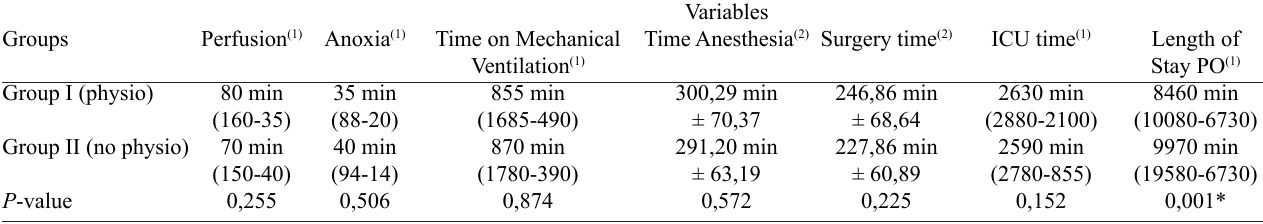
Fig. 4 - Median minute volume (VM ) variable at different times of the operation of each group analyzed. Friedman test for comparison of the moments in each group and the Mann Whitney test for comparison between groups at any time, *P<0.05. Table 3. Values for the infusion time, anoxia, mechanical ventilation, anesthesia, surgery, ICU stay and hospital stay after surgery for preoperative, 3PO and